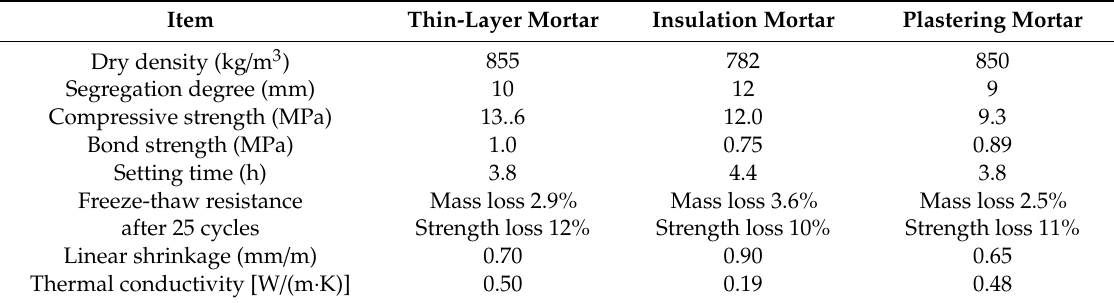
Table 3. Test results of fundamental properties of mortars.